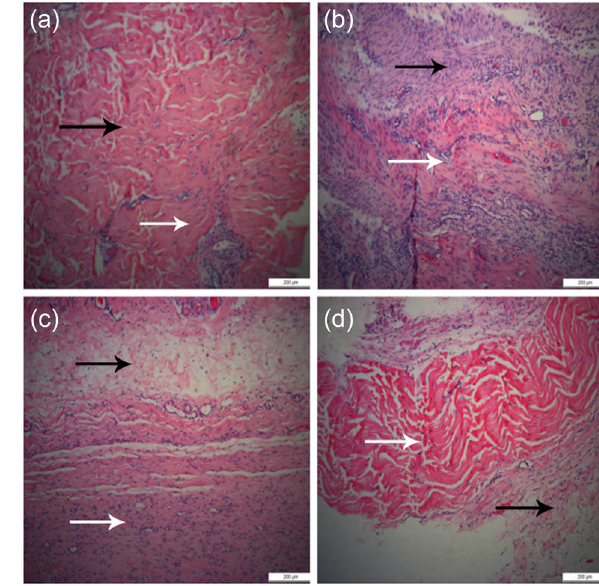
Figure 9: Photomicrographs of H&E staining of the Achilles tendons in rabbits and microscopic observations ( 100 ×) . ( a ) Group 1: the control group that received only normal saline; ( b ) Group 2: the group that received the bFGFp ( the plasmid with bFGF gene ) ; ( c ) Group 3 that received targeted microbubble ( the contrast agent with bFGFp and the target location factor, ICAM - 1 antibody ) ; ( d ) Group 4: the group that received the microbubbles with the bFGFp. ( Black arrows indicate the external tendon sheath. White arrows indicate the internal tendon sheath )